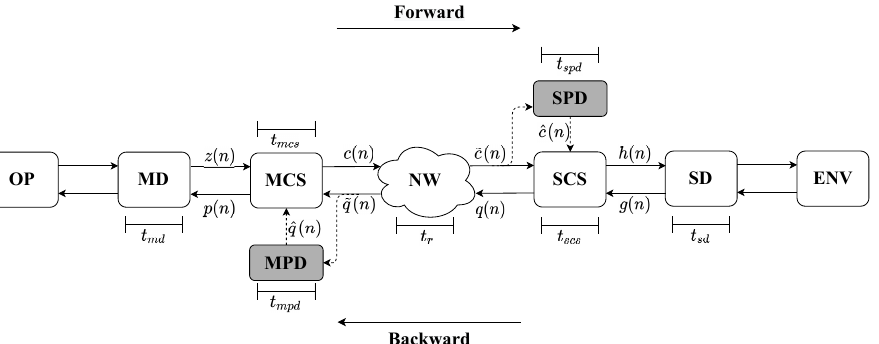
Figure 1. Block diagram illustrating the behavior of a generic Tactile Internet system that uses a parallel prediction method.